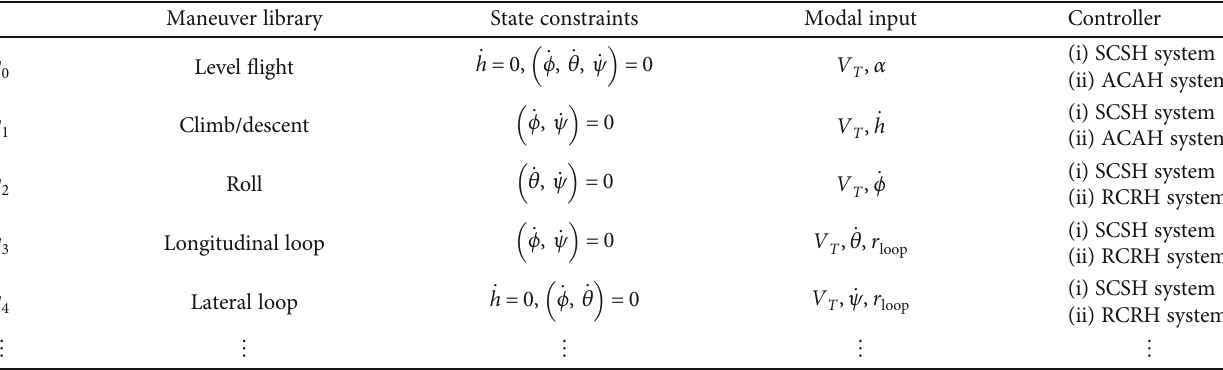
Table 2: General maneuver libraries, modal inputs, and FCS for each maneuver [2, 18]. Maneuver library